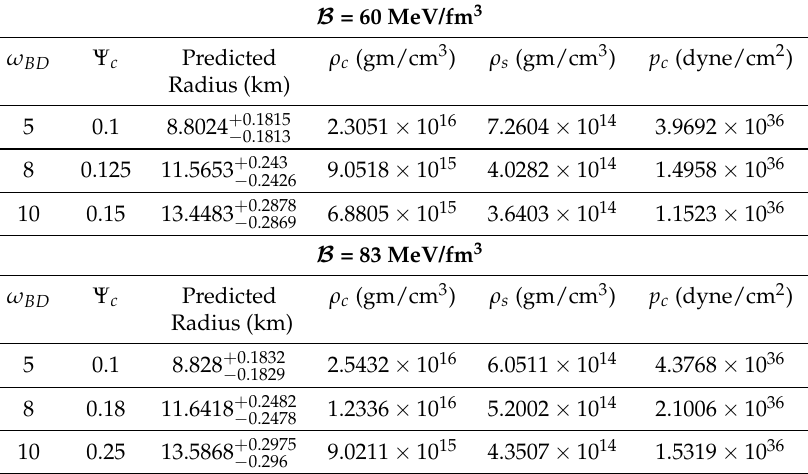
Table 1. Physical properties of PSR J1614-2230 ( M = 1.97 ± 0.04 M (cid:74) ) with m Ψ = 0.001.